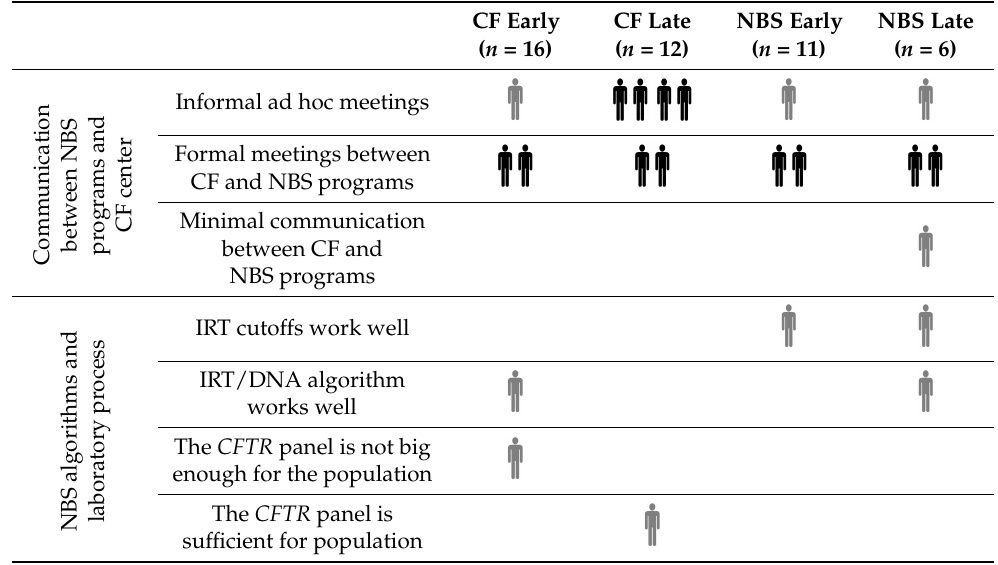
Table 1. Key themes identified listed by analysis groups; themes identified by at least 30% of the group are represented by one figure; themes identified by at least 60% are represented by two figures.